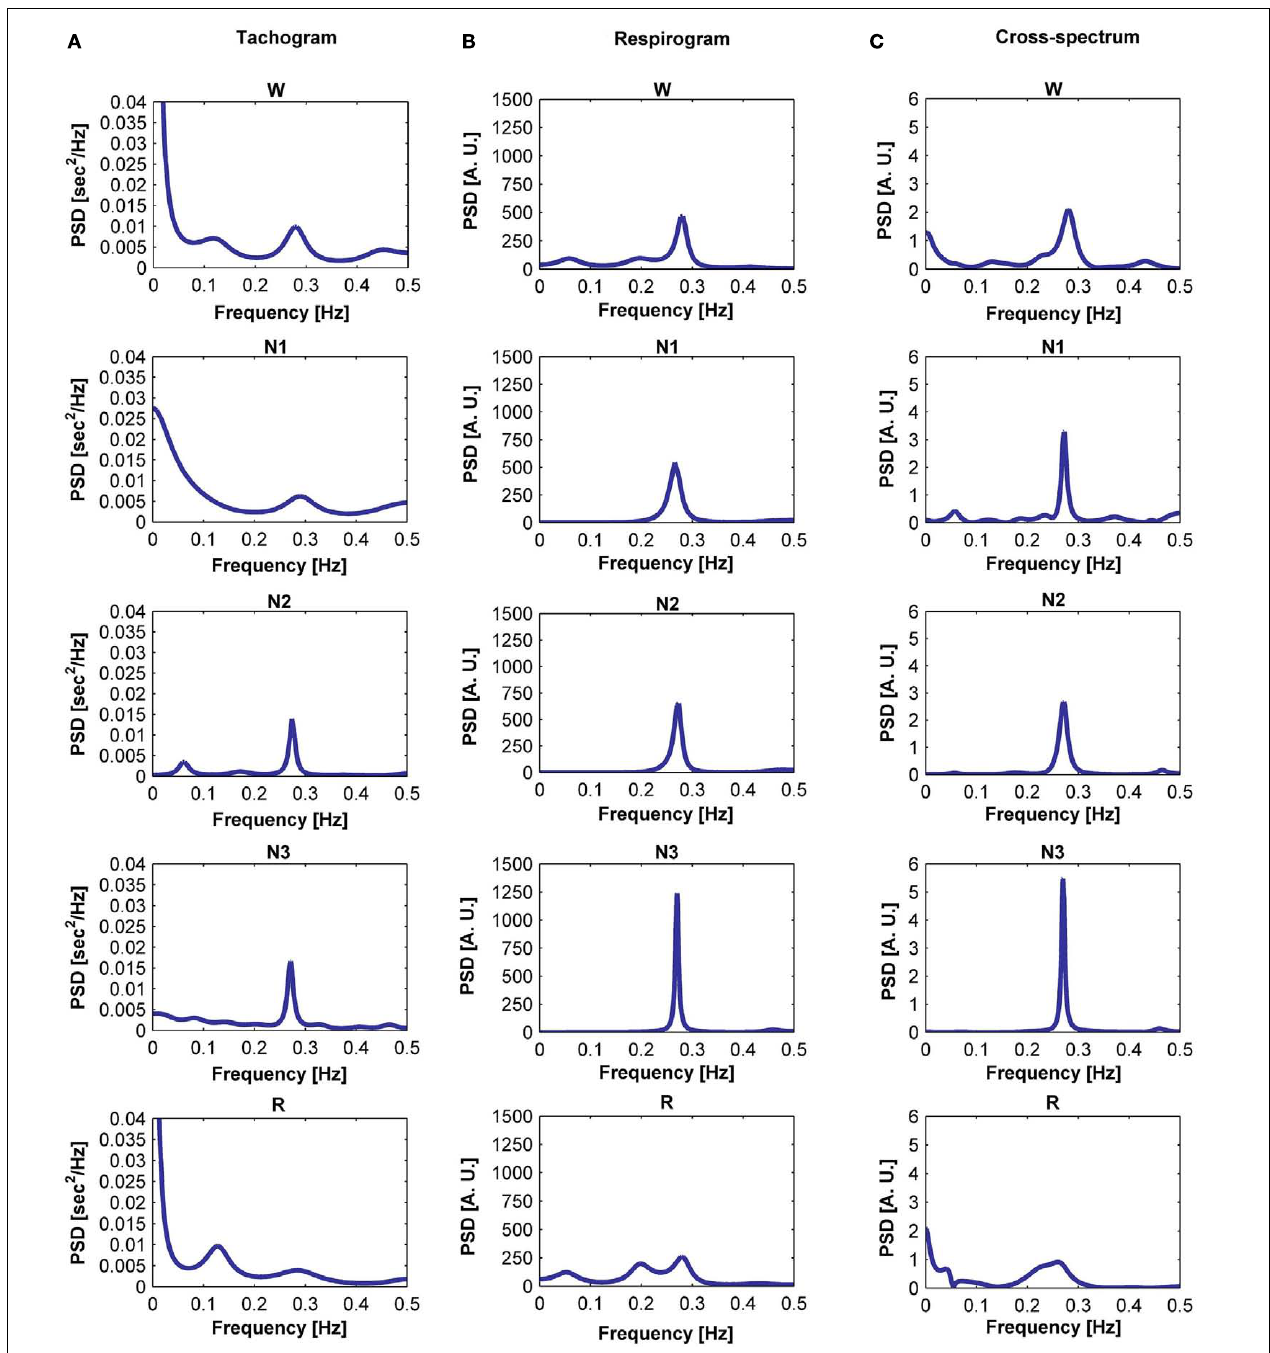
N2, and N3 and REM sleep, during the first sleep cycle (B); cross-spectrum between the tachogram and the respirogram of the same subject during wakefulness, sleep stages N1,